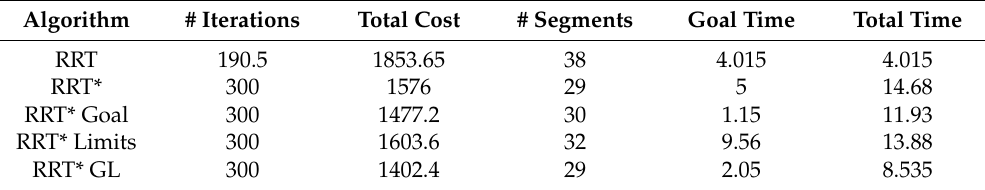
Table 7. Results. Two obstacles, 300 iterations.